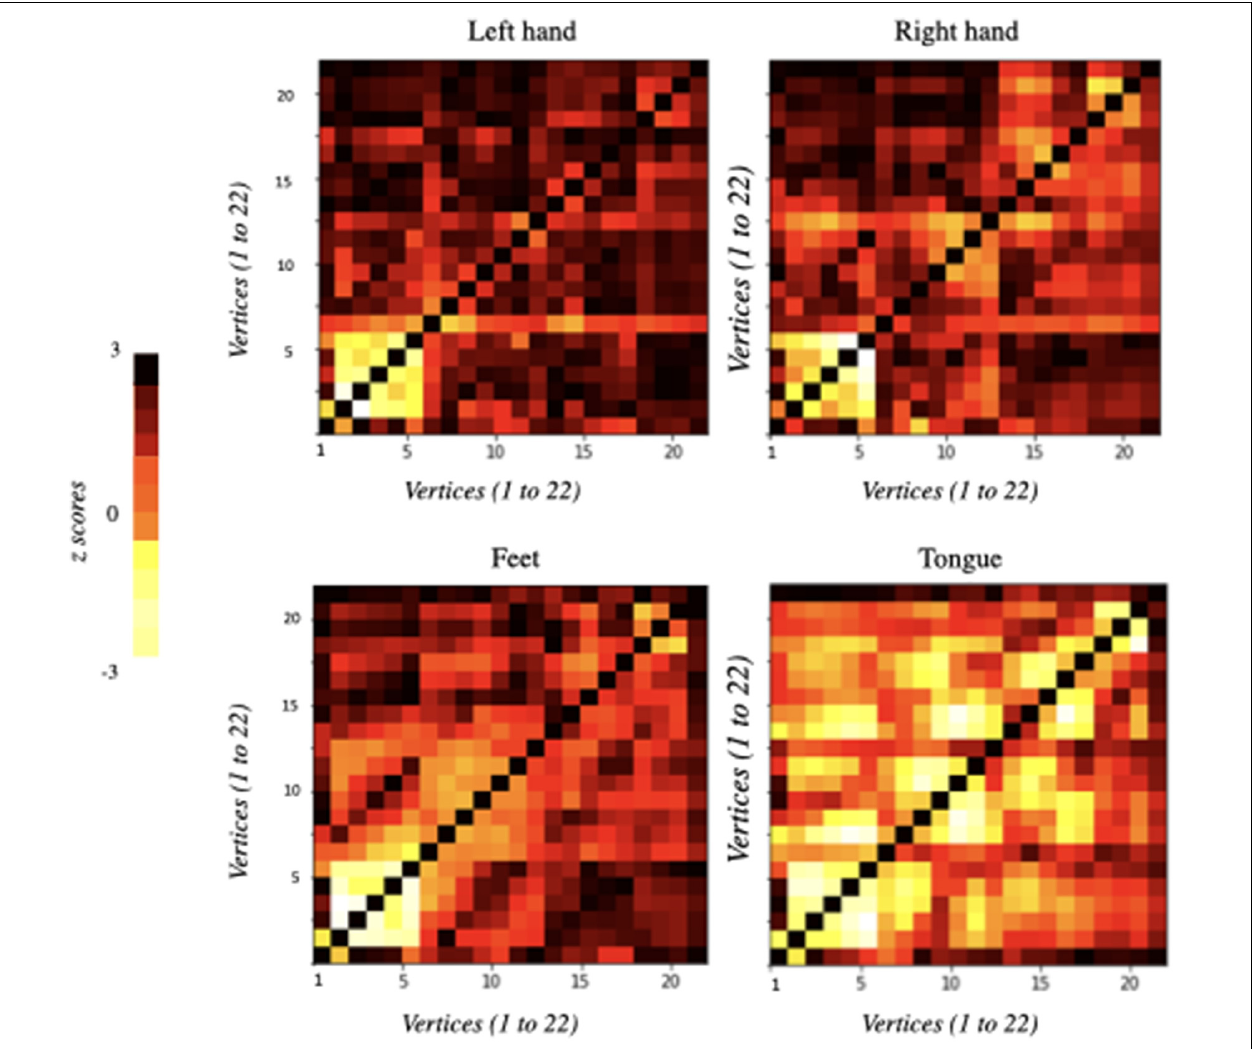
FIGURE 2 | Functional connectivity matrices obtained from the comparison of EEG data between baseline and imagery tasks. They were ordered according to the motor imagery task: left hand, right hand, feet, and tongue. Information flows from the vertices marked on the vertical axis to the vertices marked on the horizontal axis: 22 vertices × 22 vertices (i.e., 22 electrodes × 22 electrodes). Each element of the correlation matrix shows z-scores corresponding to each node comparison. Statistically significant results were only obtained for tongue motor imagery ( p <